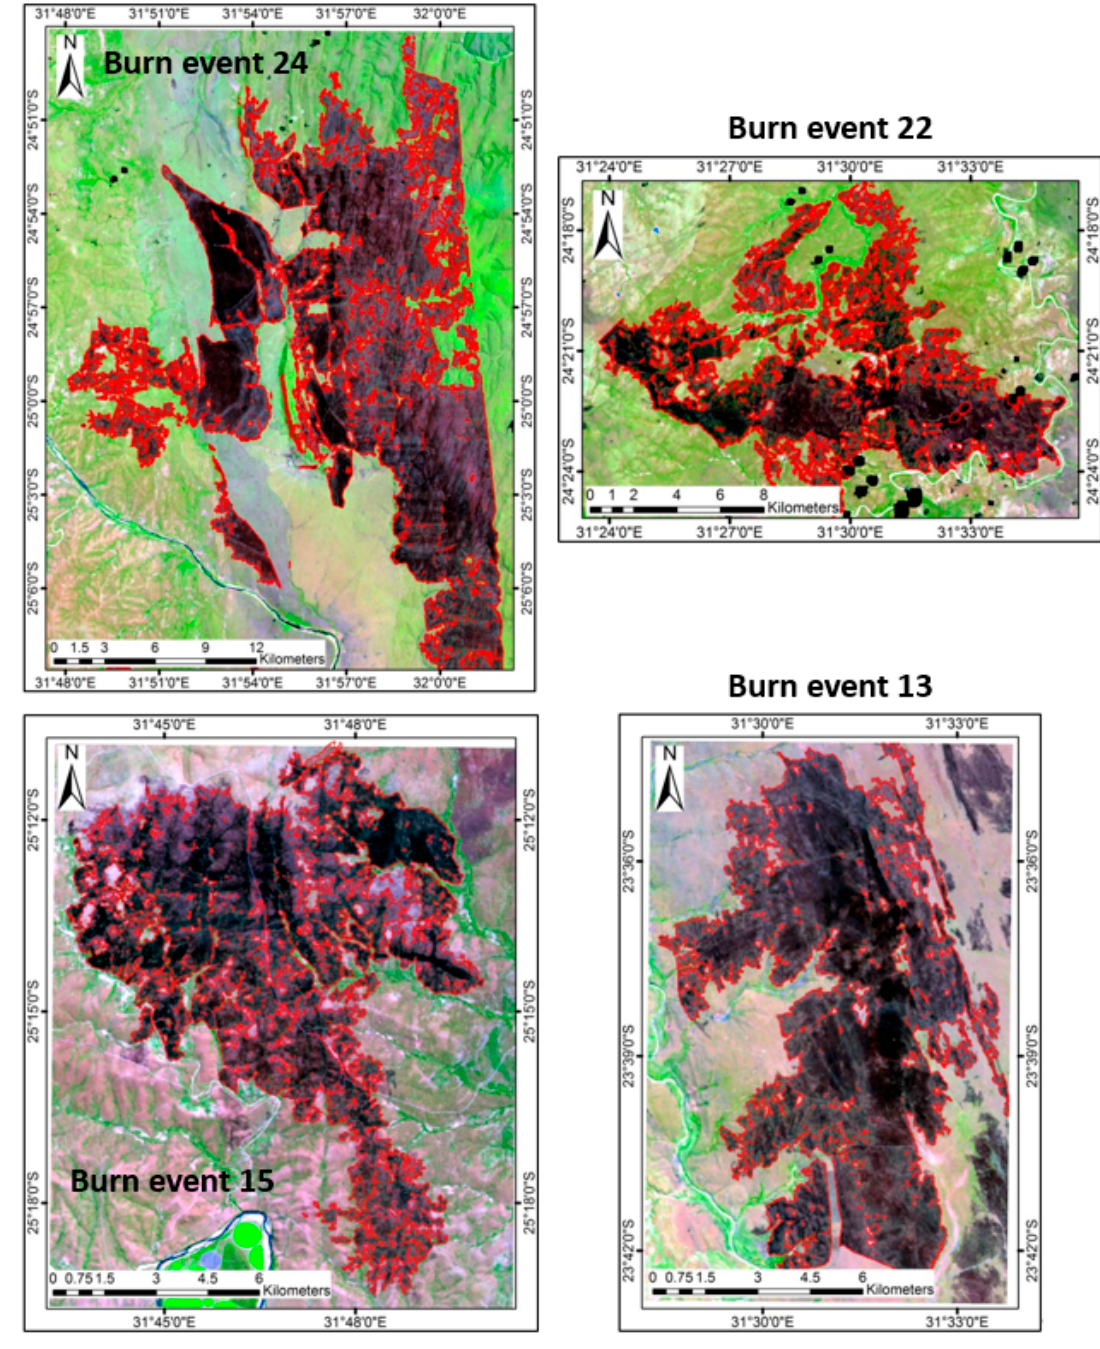
Figure 4. Example of KNP 2015 burned areas extracted from 30 m Landsat operational land imager (OLI) images (shown in false color composites, RGB band 6, 5, 4 respectively). Red boundaries show the extracted Landsat burned areas used as reference burned areas for the analysis of the Sentinel-1 data.